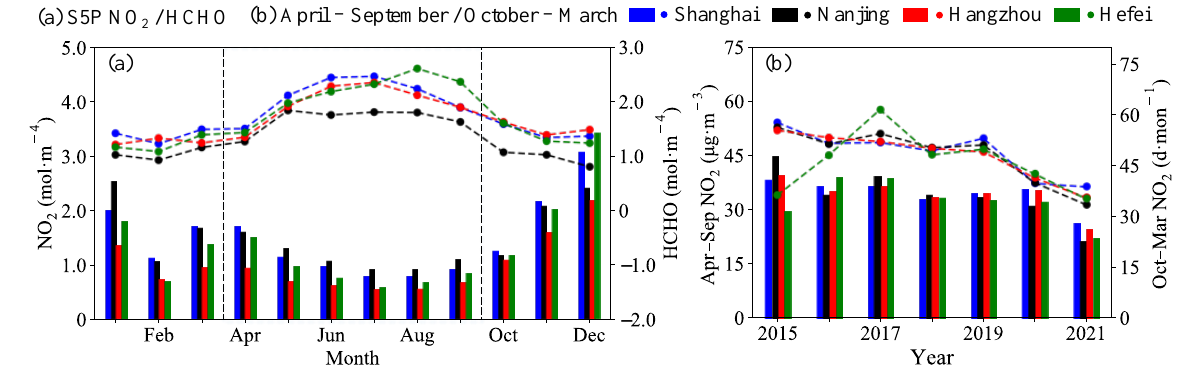
Figure A1. Daily variation of O 3 and meteorological conditions, including air temperature (AT), relative humility (RH), and sunshine duration (SD) over the four capital cities ( a ) Shanghai, ( b ) Nan- jing, ( c ) Hangzhou, ( d ) Hefei in the Yangtze River Delta.